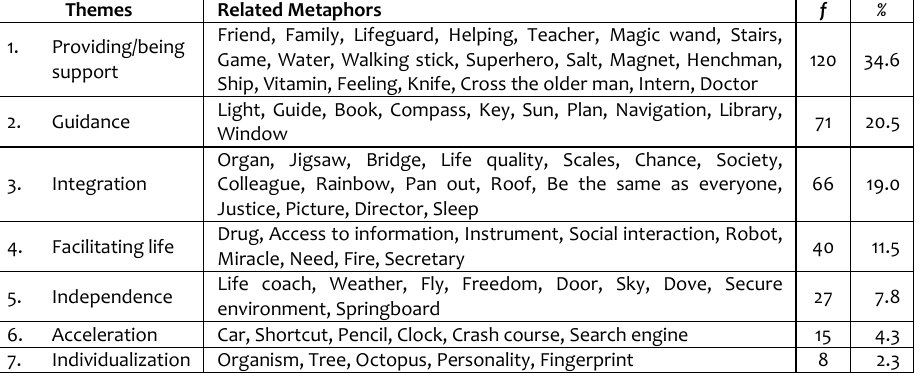
Table 2. Themes of metaphors created by special education pre-service teachers for the concept of